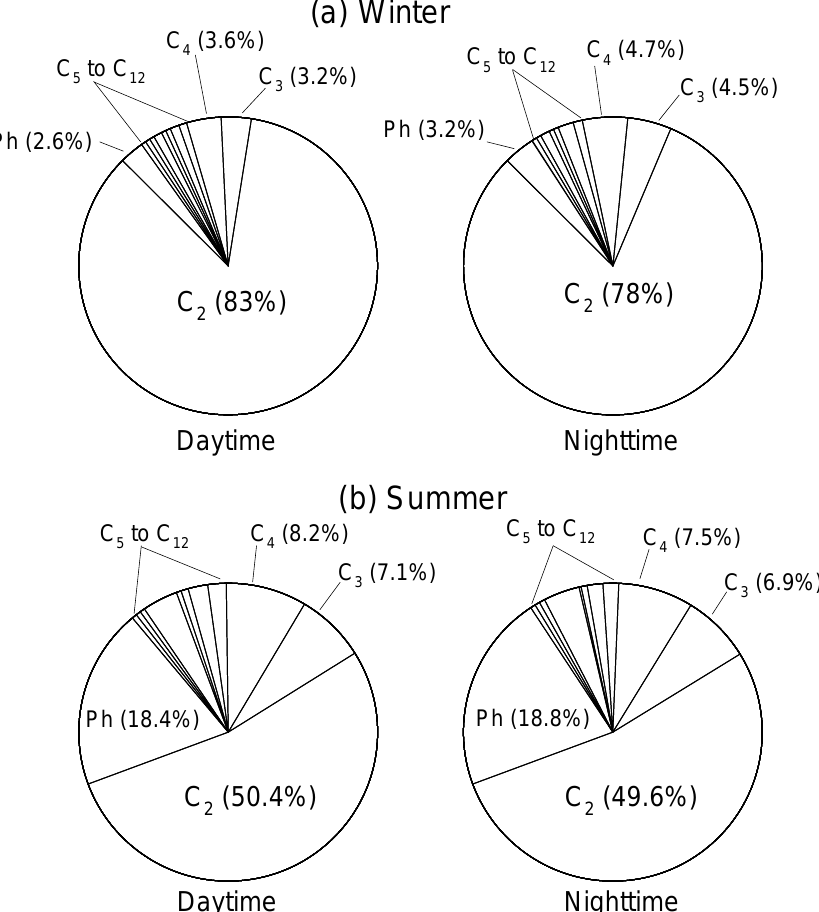
Fig. 7. Pie diagrams of relative abundances (%) of individual diacid in total straight-chain diacids in aerosols collected during (a) winter and (b) summer seasons in Nainital,